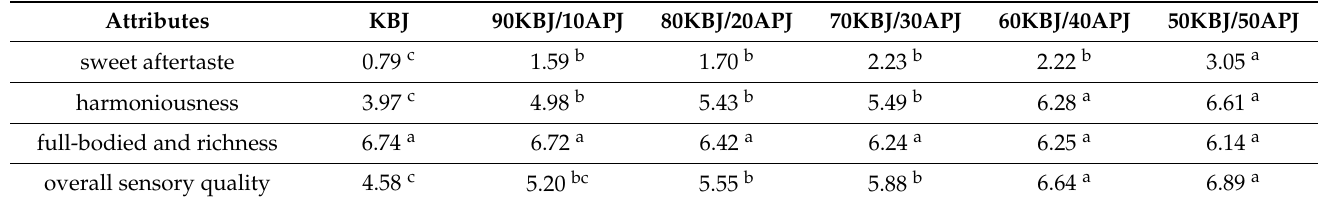
Table 4. Sensory profiling of the kiwiberry juice and kiwiberry/apple juice mixtures.